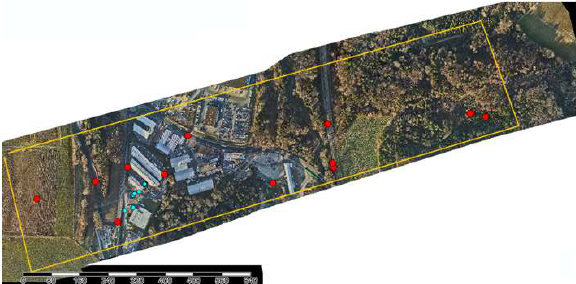
Figure 3: Experimental site near Aclens, Switzerland. Red dots represent GCPs and blue dots the check points.